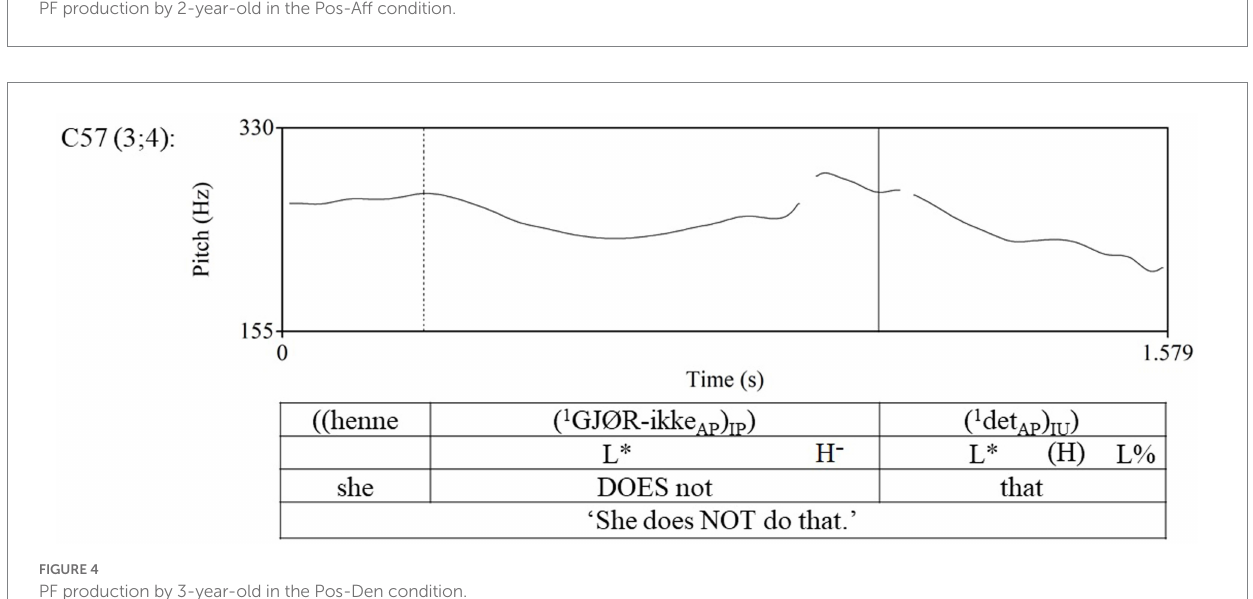
FIGURE 4 PF production by 3-year-old in the Pos-Den condition.